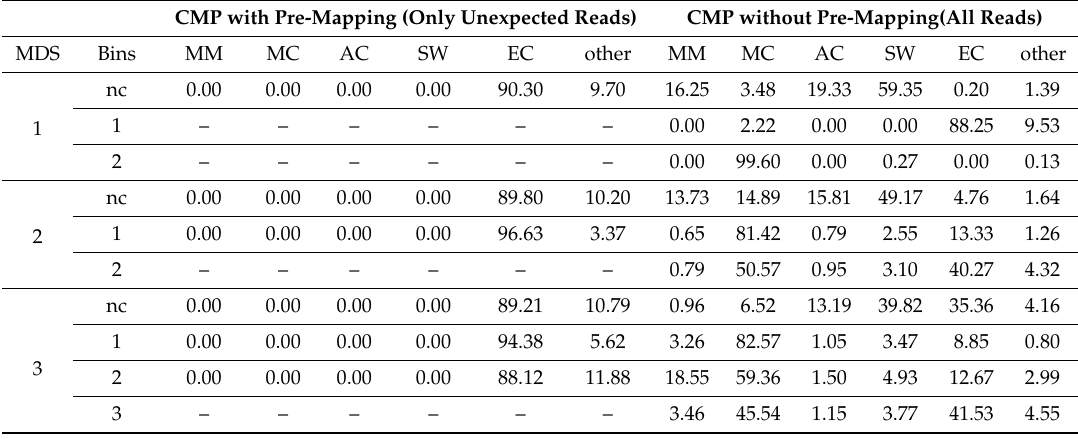
Table 5. Composition of bins compared between the CMP with and without pre-mapping for all three mock data sets (MDS) in relative abundances (%). Pre-mapping successfully removes reads associated with expected species, only leaving E. coli reads for assembly and binning. CMP with Pre-Mapping (Only Unexpected Reads) CMP without Pre-Mapping(All